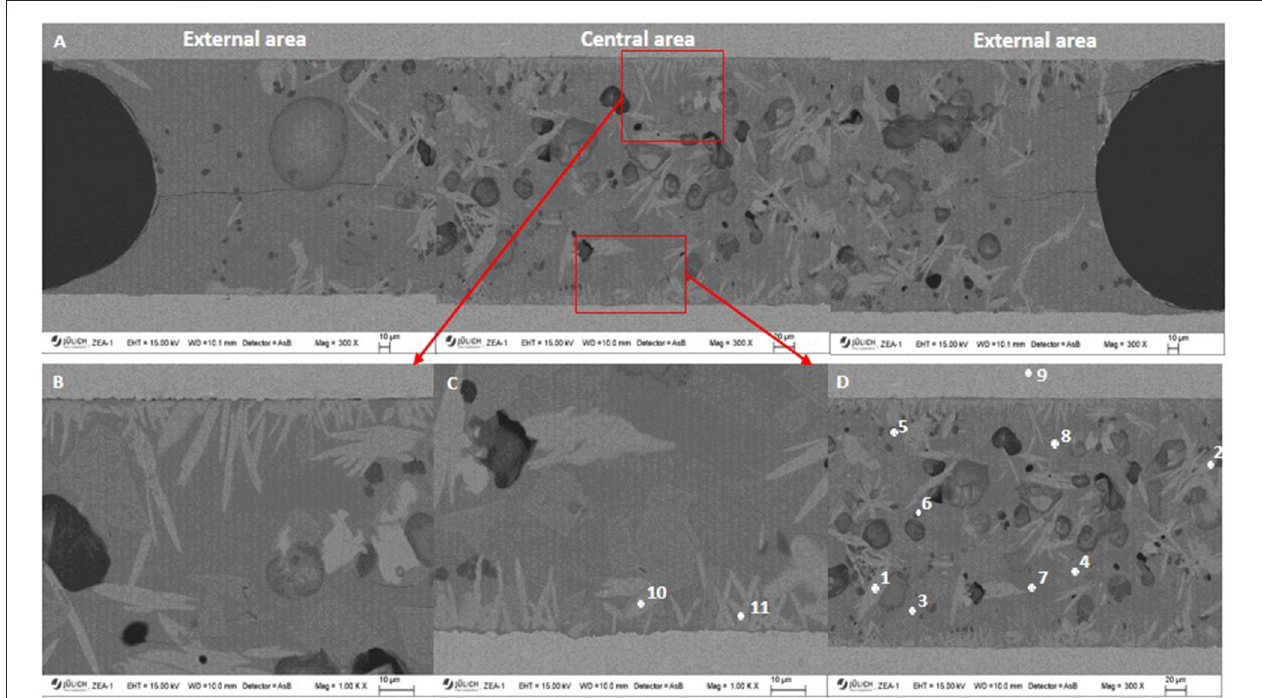
FIGURE 5 | SEM images of the joint Crofer22APU-glass-ceramic seal 10B(Sr) after sealing at 850 ◦ C for 10h. (A) General image of the joint showing the outer and central areas. (B,C) Detail of the joint between steel and sealant. (C,D) Microstructure of the seal and punctual elemental analysis by EDX.